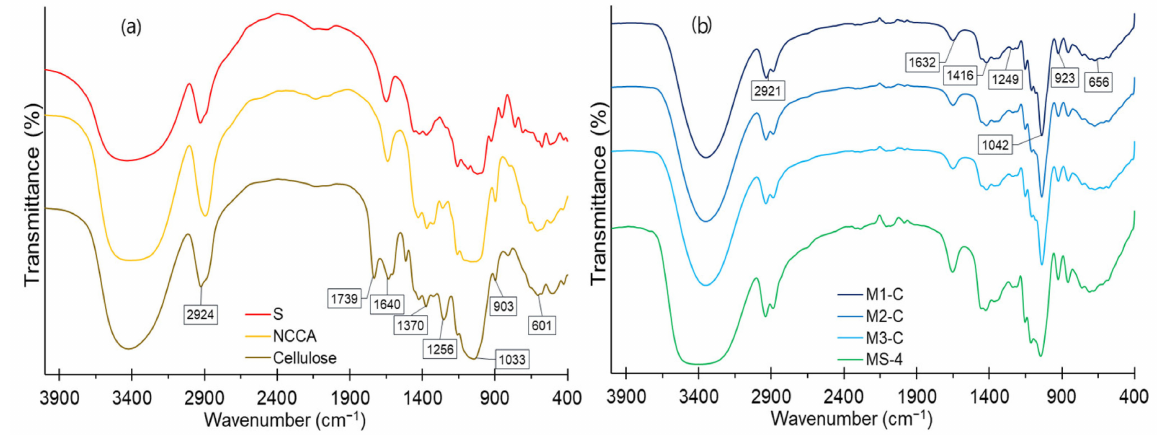
Figure 7. ( a ) FTIR spectrum for raw materials, ( b ) FTIR spectrum for